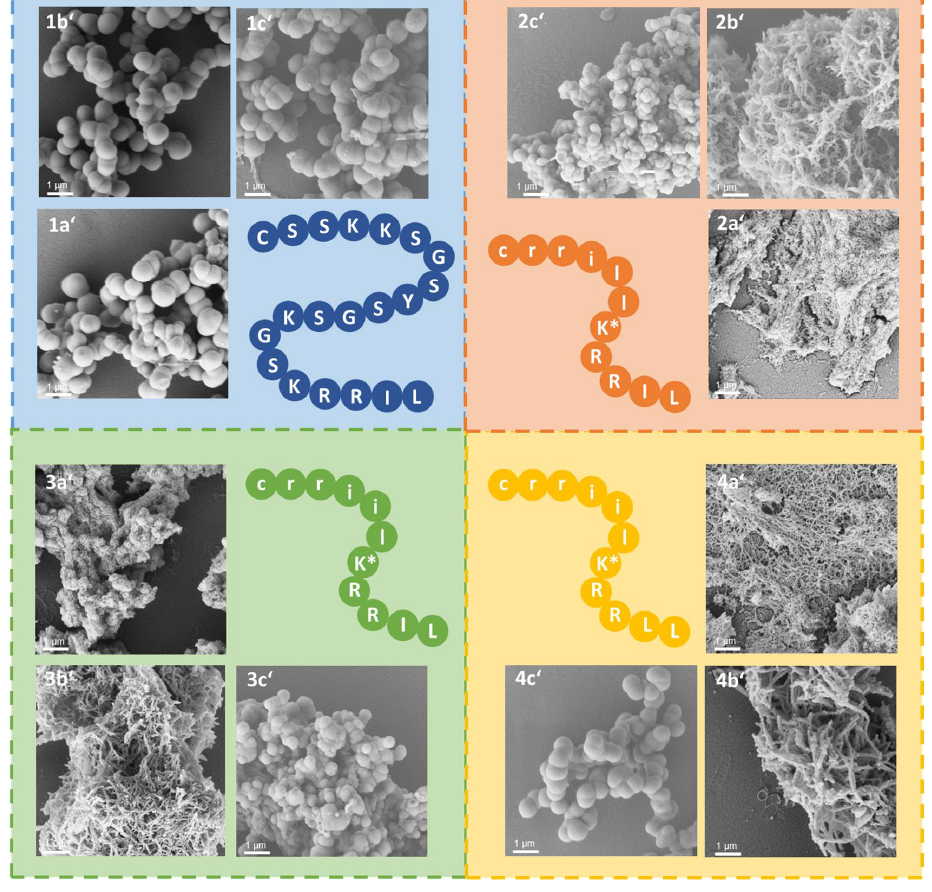
Figure 5. SEM images of silica particles generated from CysR5, RRIL-1 2 , RRIL-2 3 and RRLL 4 conjugated to P467 a , Bet v 1 b and Phl p 5 c . CysR5-related structures are displayed in blue, RRIL-1- related structures in orange, RRIL-2-related structures in green and RRLL-related structures in yellow. Scale bar represents 1 µ m. * Indicates branching via the lysine (K)